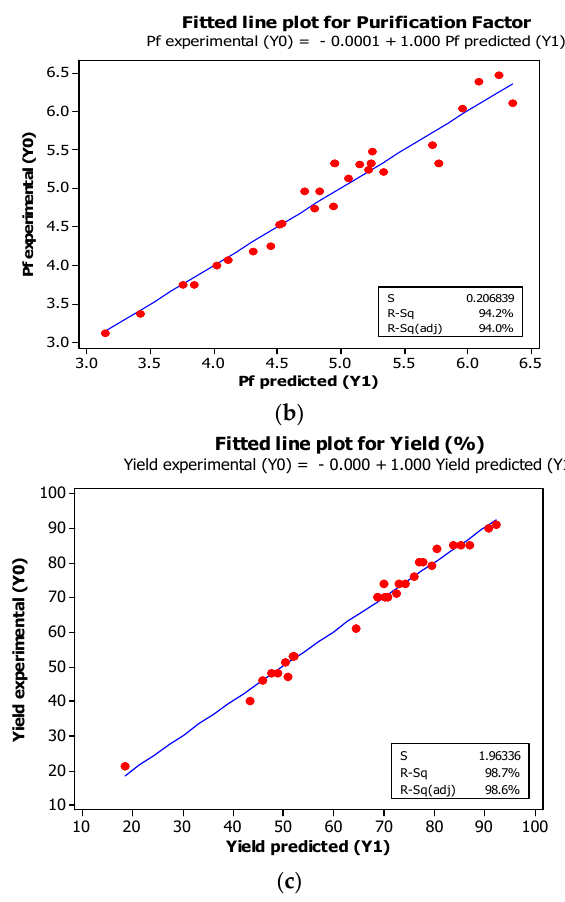
Figure 2. Fitted line plots for predicted (Y1) and experimental values (Y0). Partition coefficient ( a ), purification factor ( b ) and yield % ( c ) of purified protease.